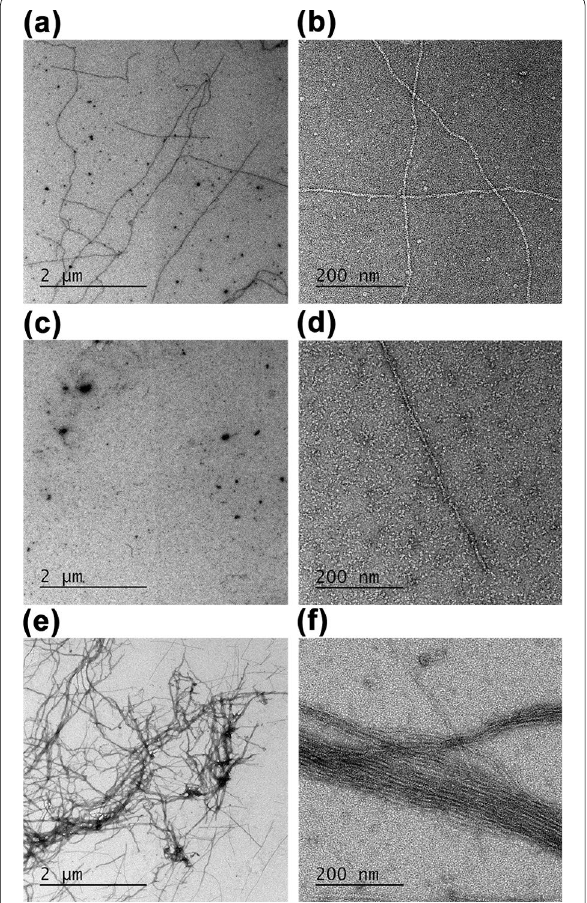
Fig. 1 Electron microscopic analysis of actin‑severing and bundling activities of gelsolin and ABP34 in the presence of Ca 2 + . Negative staining (NS) electron micrographs taken from F‑actin alone ( a , b ); mixture of F‑actin and gelsolin ( c , d ); mixture of F‑actin and ABP34 ( e , f ). All the samples were mixed in low ionic strength buffer (at a molar ratio of 1:1; final concentration 3 μM). In the presence of Ca 2 + , actin‑binding proteins typically exhibited their native activity. NS‑electron micrographs were taken at both low 4200 ( a , c and e ; left panels) and high 34,000 ( b , d and f ; right panels) nominal magnifications. Scale bars represent 2 μm ( a , c and e ) and 200 nm ( b